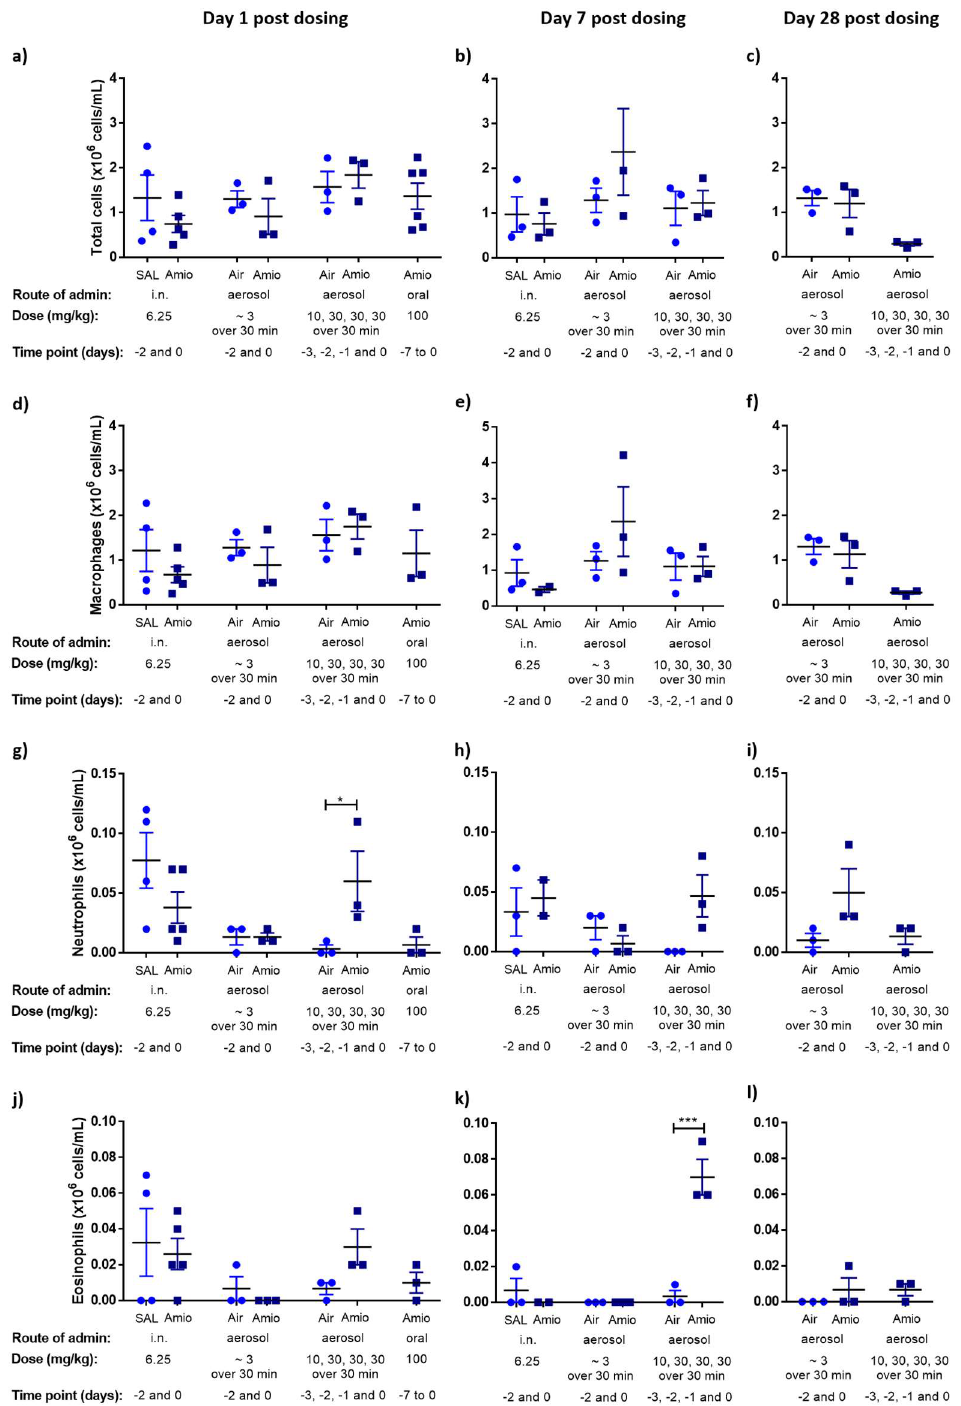
Figure 1. Effect of intranasal (i.n.), aerosol or oral amiodarone exposure on the total number of cells, macrophages, neutrophils and eosinophils recovered by bronchoalveolar lavage (BAL). Rats were exposed to amiodarone, sterile saline (SAL) or air (control) at various time points (days) and subjected to BAL at day 1, day 7 or day 28 post-dosing ( a – c ). Total cell number recovered by BAL, ( d – f ) number of alveolar macrophages recovered by BAL, differential counts of ( g – i ) neutrophils and ( j – l ) eosinophils recovered by BAL. Columns represent mean ± SEM ( n = 2–5 per treatment group); two-way ANOVA with post hoc Bonferroni Test, Difference from respective saline or air controls; * p < 0.05, *** p < 0.001, statistically significant compared with the respective control, two-way ANOVA with post hoc Bonferroni test.